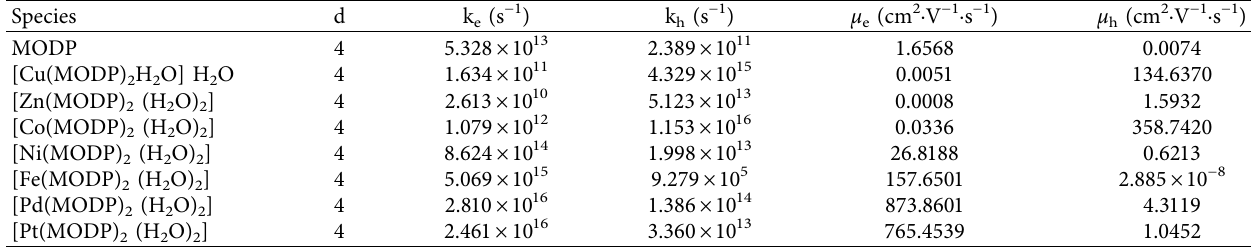
Table 10: Charge transfer rate values ( k of theory in the gas phase.